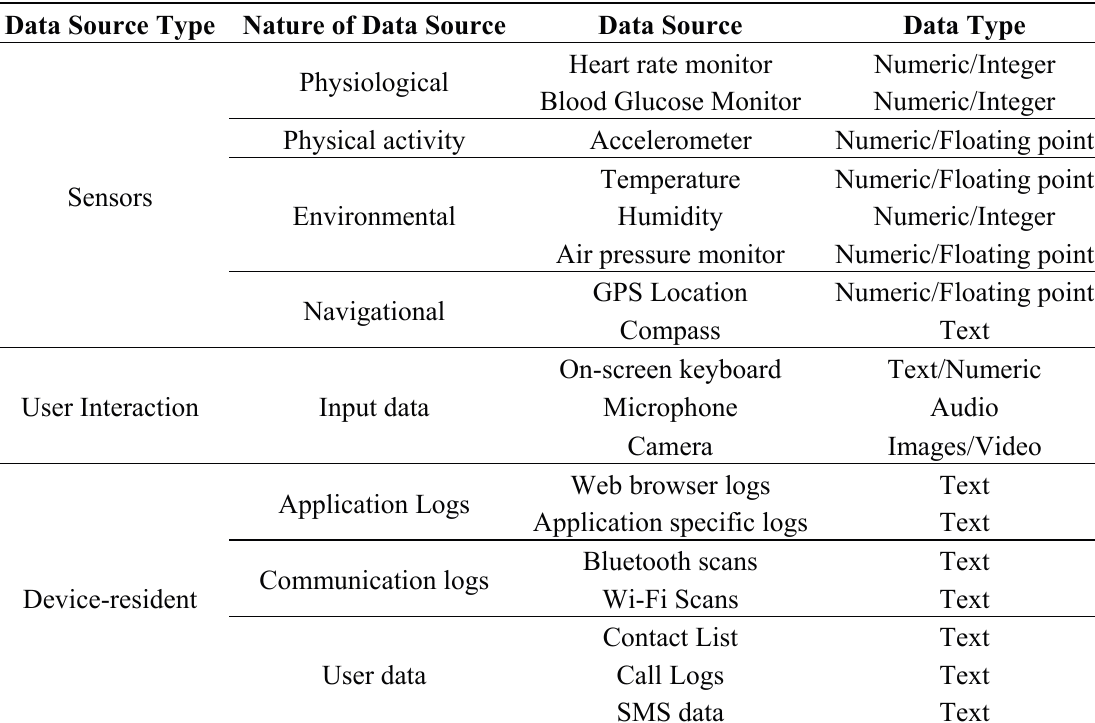
Figure 1. Data lifecycle in PEs. Table 2. Personal Data in